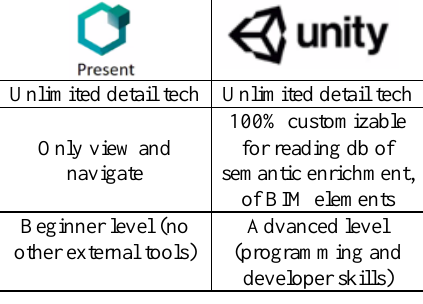
Table 3 . Pros and